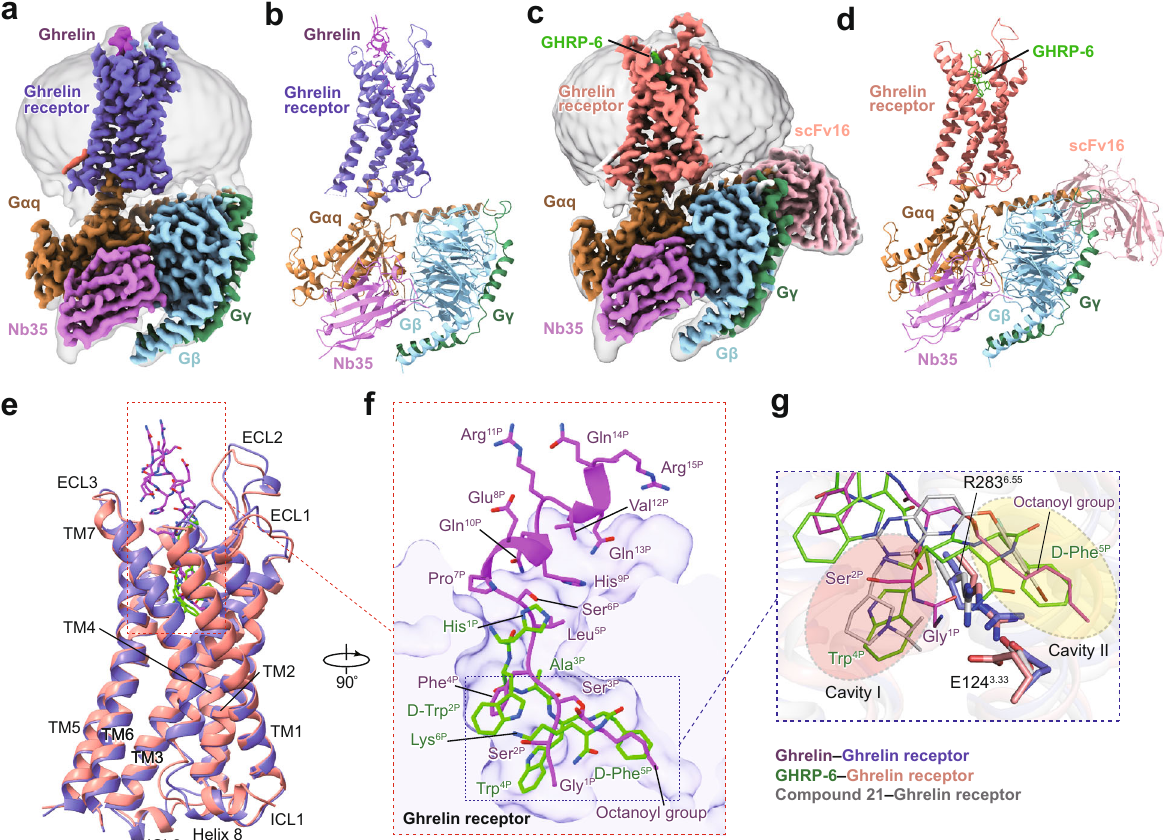
Fig. 1 Cryo-EM structures of the G q -coupled ghrelin receptor bound to ghrelin and GHRP-6. a , b Orthogonal views of the density map ( a ) and model ( b ) for the ghrelin – ghrelin receptor – G q – Nb35 complex. The density map is shown at 0.104 threshold. c , d Orthogonal views of the density map ( c ) and model ( d ) for the GHRP-6 – ghrelin receptor – G q – Nb35 – scFv16 complex. The density map is shown at 0.1 threshold. e Structural superposition of ghrelin-bound and GHRP-6-bound ghrelin receptors. f Binding poses of ghrelin and GHRP-6. Two peptides occupy a similar orthosteric binding pocket with opposite orientation. g Binding pocket of ghrelin receptor is bifurcated into two cavities by a salt bridge between E124 3.33 and R283 6.55 . Salmon oval, cavity I; yellow oval, cavity II. Ghrelin is shown in magenta, ghrelin-bound ghrelin receptor in slate blue. GHRP-6 is displayed in green, and GHRP-6 bound ghrelin receptor in salmon. Compound 21-bound ghrelin receptor (PDB: 6KO5) is colored gray. The G q heterotrimer is colored by subunits. G α q : peru, G β : light sky blue, G γ : sea green, Nb35: orchid, scFv16: light